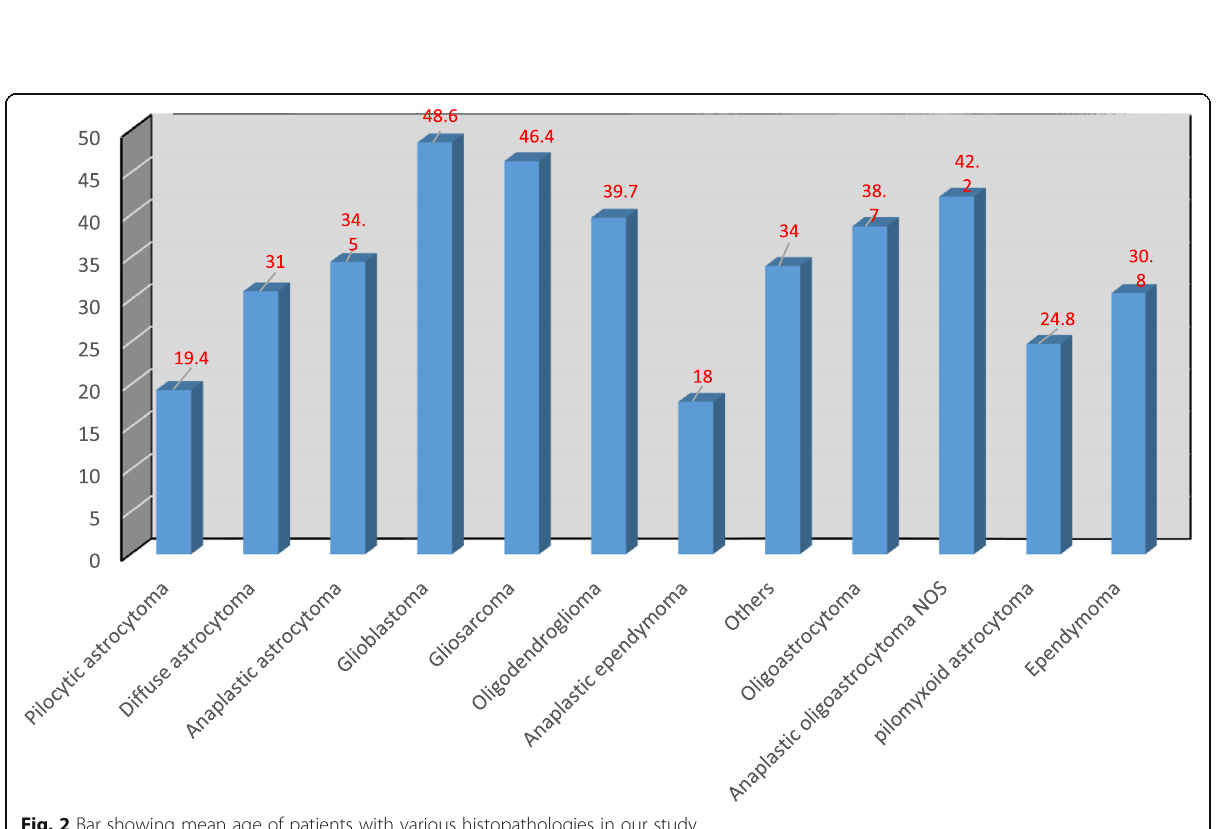
Fig. 2 Bar showing mean age of patients with various histopathologies in our